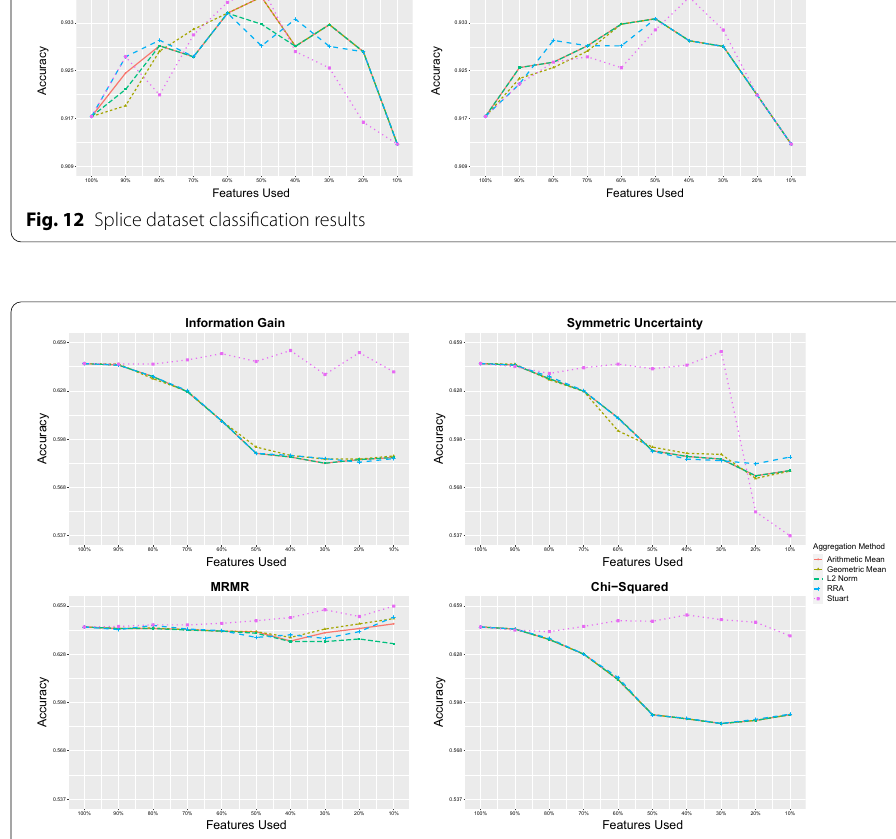
Fig. 13 Indian Pines dataset classification